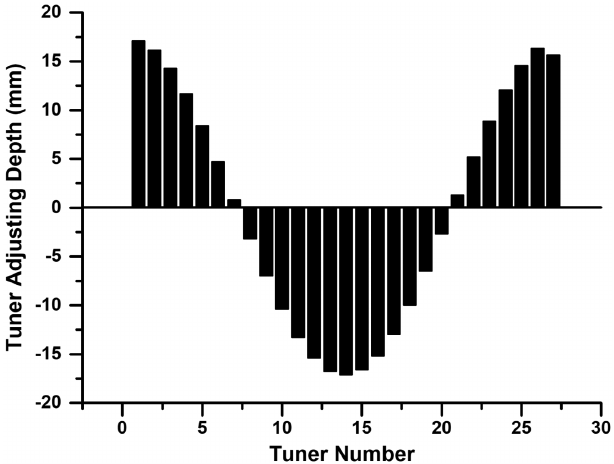
FIG. 14. Adjusting depth of the HIAF RFQ tuners to achieve the field flatness of (cid:2) 2% from (cid:2) 5%